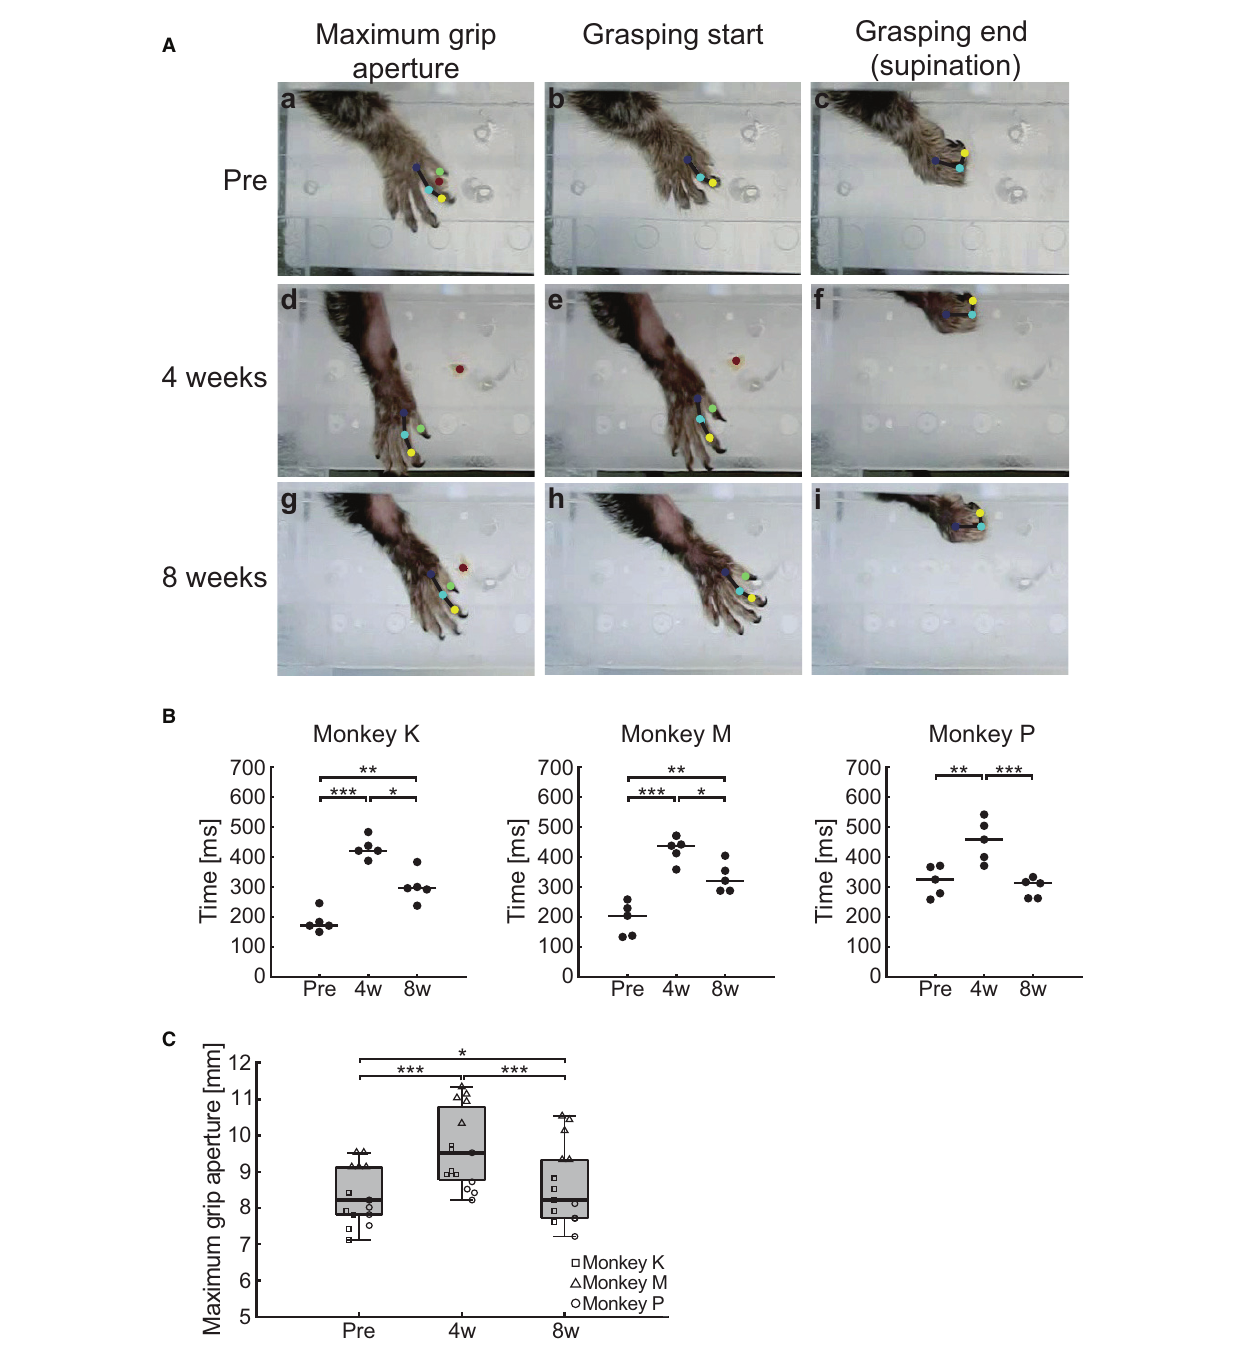
FIGURE6 Behavioral results of grasping function. (A) Representative images of the grasping movement before, 4 weeks, and 8 weeks after creation of the lesion from one representative marmoset (Monkey M). Blue, cyan, yellow, and green circles indicate the position of the index finger MP, PIP, and DIP joint, and the thumb IP joint, respectively. Red circle indicates the position of the food pellet. (B) Time course of the transition in the grasping time in each marmoset. Black lines indicate median value of each time point. * p < 0.05; ** p < 0.01; *** p < 0.001. (C) Time course of the transition in the maximum grip aperture. Box plots indicate the median (black line in the box), interquartile range (IQR; gray box), and the lowest and highest data (error bars). * p < 0.05, *** p < 0.001.